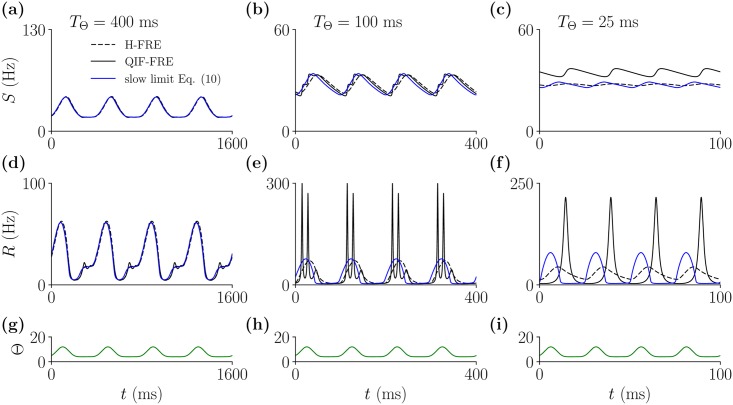
The reduction of the QIF-FRE to Eq (10) breaks down when neurons receive time-varying inputs.Panels (a-c): S-variable time series for QIF-FRE (solid Black), H-FRE (dashed Black) and Eq (10) (Blue), for decreasing values of the period TΘ of the external periodic forcing Θ(t) = 4 + [1 + sin(2πt/Tθ)]3 —shown in panels (g-i). In all cases, the synaptic time constant is slow τd = 100 ms, compared to the membrane time constant τm = 10 ms. Panels (d-f): R-variable time series. In the case of model Eq (10), the firing rate has been evaluated using Eq (9). Other parameters are J = 21, Δ = 0.3.